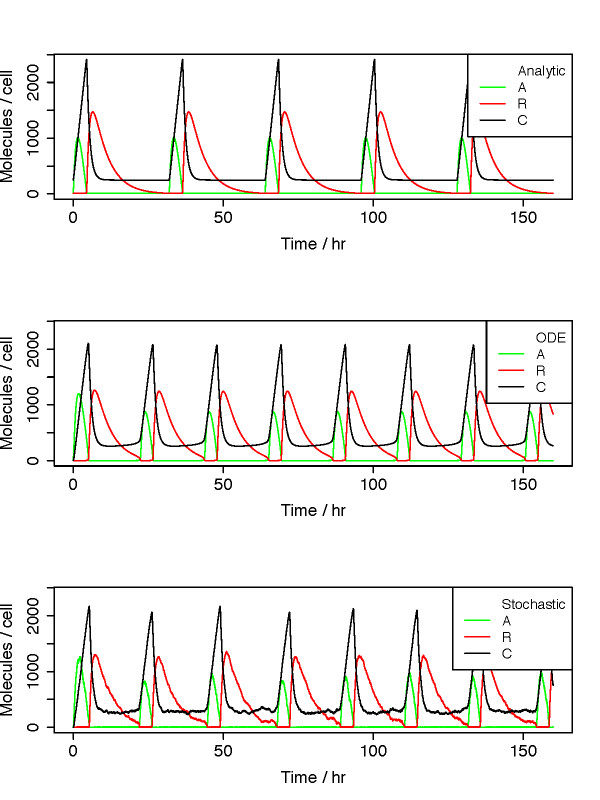
Trajectories of activator, repressor, and complex concentrations are displayed for dynamics from analytical expressions (top panel), continuous ODEs (middle), and stochastic simulations (bottom). Parameter values are exactly as in Ref. [11], provided in Table 1, except with Hill coefficient = 2 to reflect cooperative dimer binding.